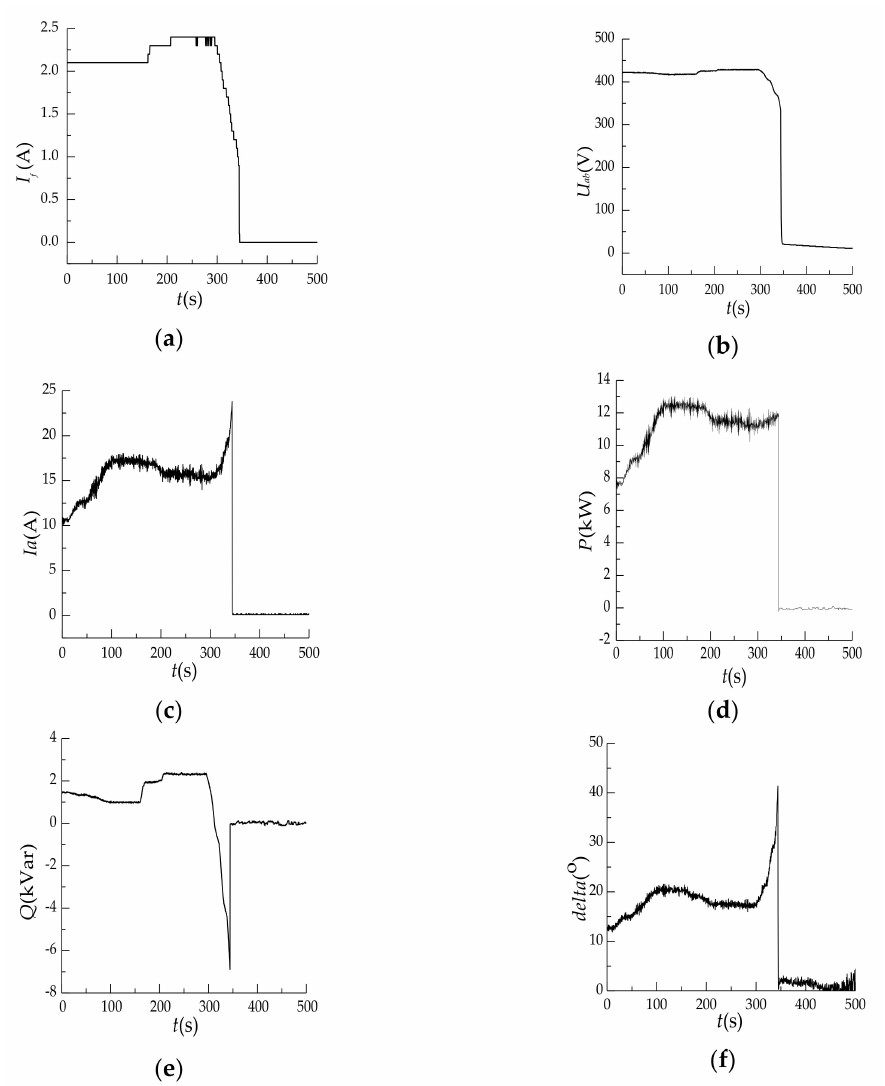
Figure 13. Electrical-parameter variation curves: ( a ) Excitation current; ( b ) Terminal voltage; ( c ) Stator winding current; ( d ) Active power; ( e ) Reactive power; ( f ) Power angle. For the rated load of 96% and a power factor of − 0.834 in the leading phase condition, the magnetic-field line cloud diagram and magnetic-flux density distribution diagram of the internal magnetic field and the air gap of the generator are shown in Figures 14 and 15, respectively. In the air gap, the distribution of magnetic lines is denser, and the magnetic density is